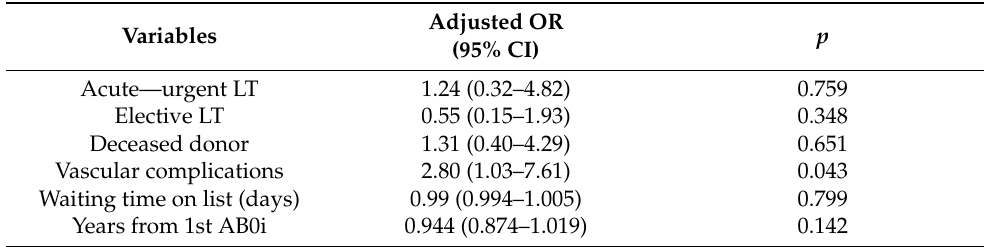
Table 7. Risk factors for recipient death. Multivariable analysis (logistic regression): only factors with p -value < 0.1 according to a univariate analysis were